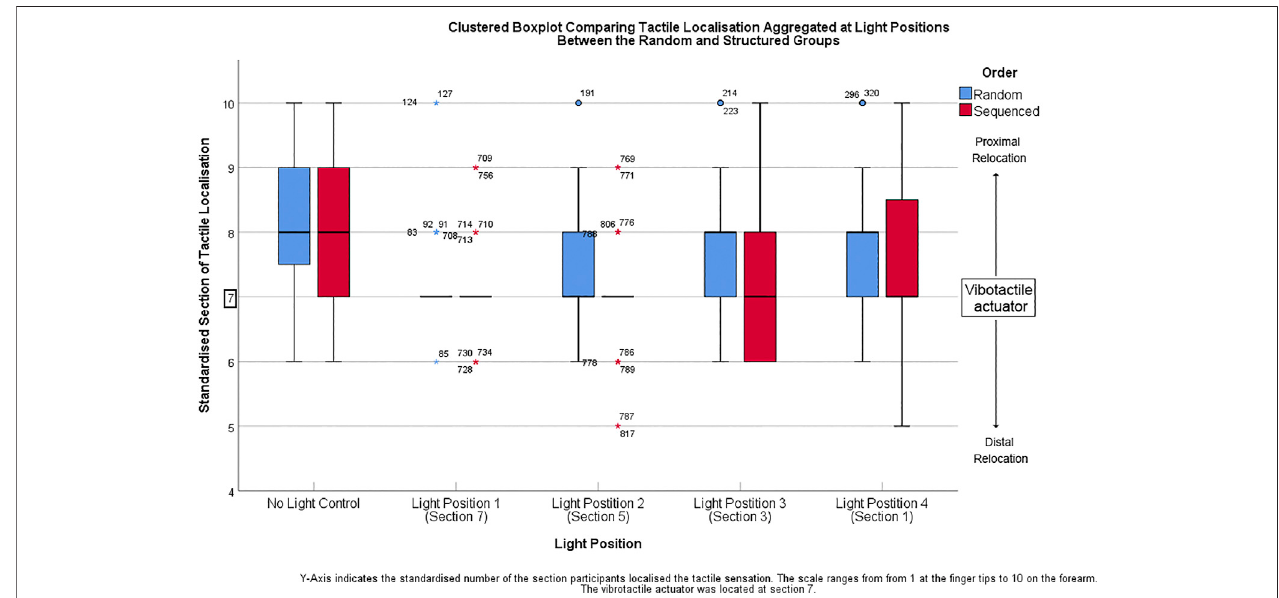
FIGURE2| Y-Axisshowsthestandardised numberofthesection participantslocalisedthetactilesensation.Thescalerangesfrom1atthe fi ngertipsto10onthe forearm.